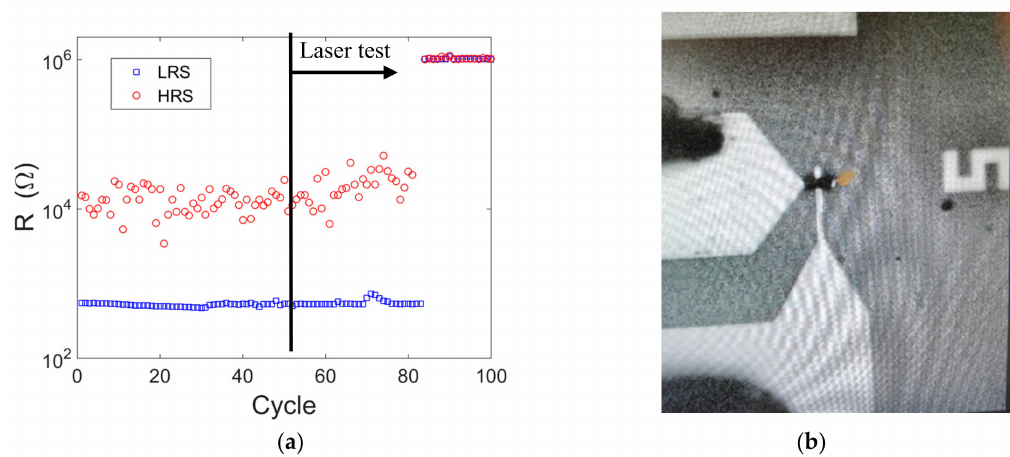
Figure 9. ( a ) Equivalent resistance for a RRAM during the experiment where the laser source released energy continuously; and ( b ) Photograph of the RRAM after the